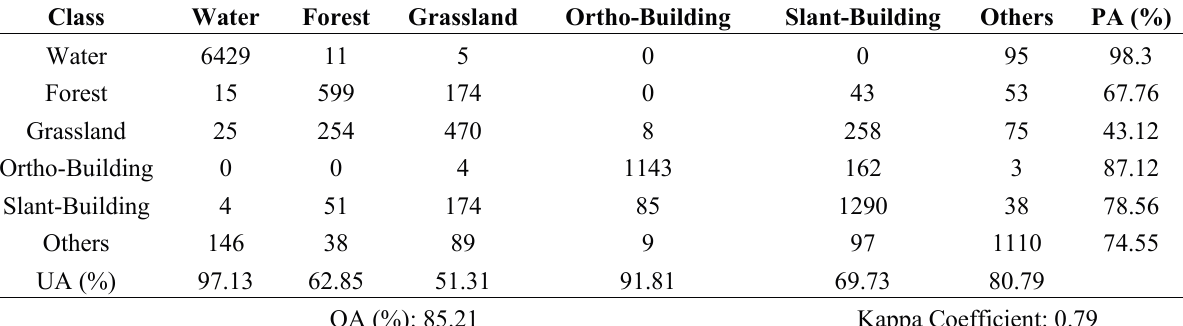
Table 4. Confusion Matrix of H (entropy)/A (anisotropy)/ α(cid:3365) (scattering angle)-C5